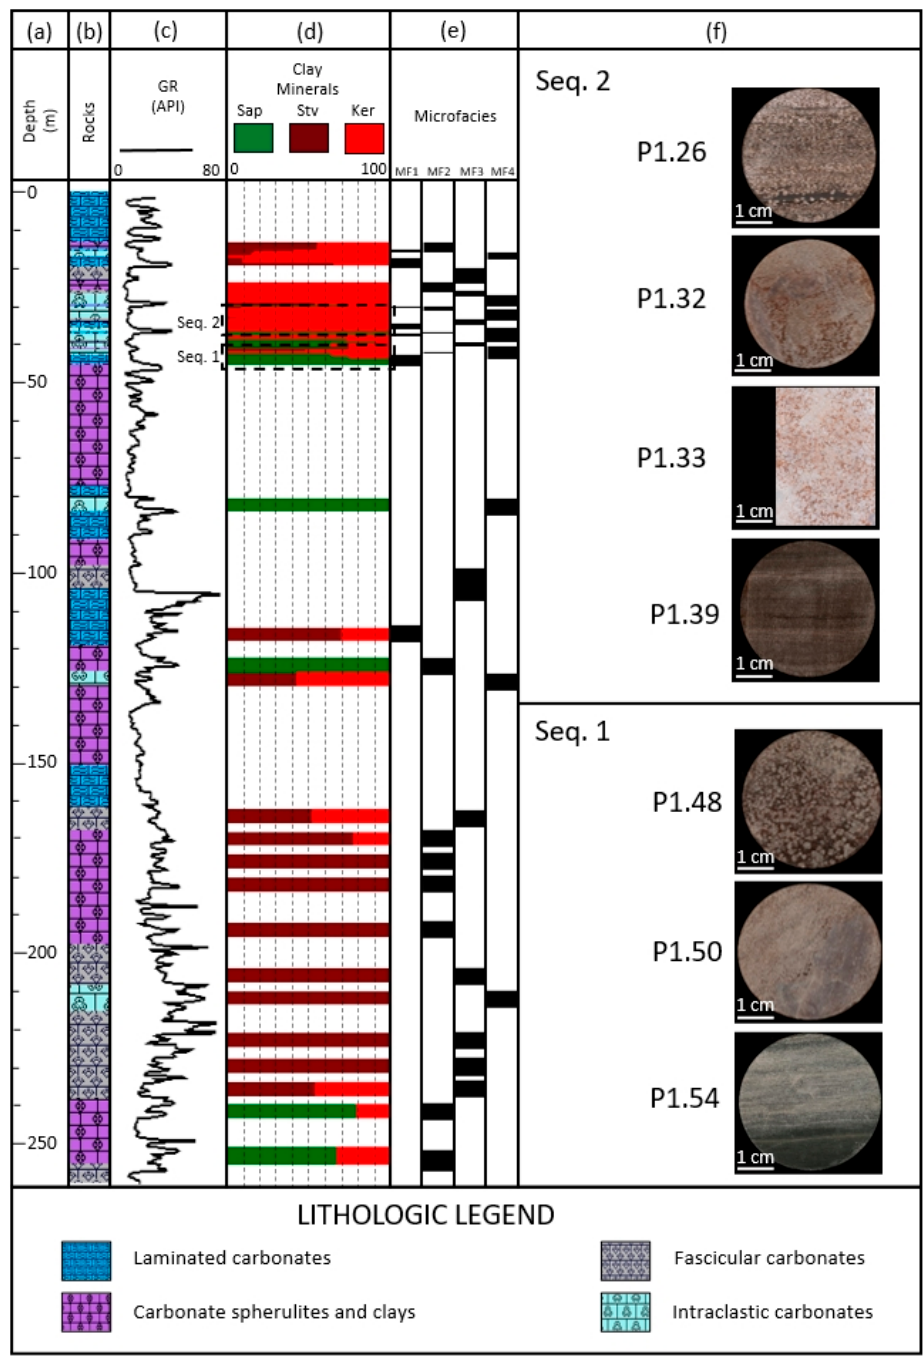
Figure 4. Schematic lithological section from well P1, showing: ( a ) Depth. ( b ) Lithological section. ( c ) Gamma-ray profile. ( d ) Clay mineralogy (the dashed rectangles indicate the mineralogical se- quences 1 and 2). ( e ) Microfacies. ( f ) Representative hand samples from the differentiated lithofacies in sequences. Zero-meter depth representing the top of the Barra Velha Fm (modified from [2]).